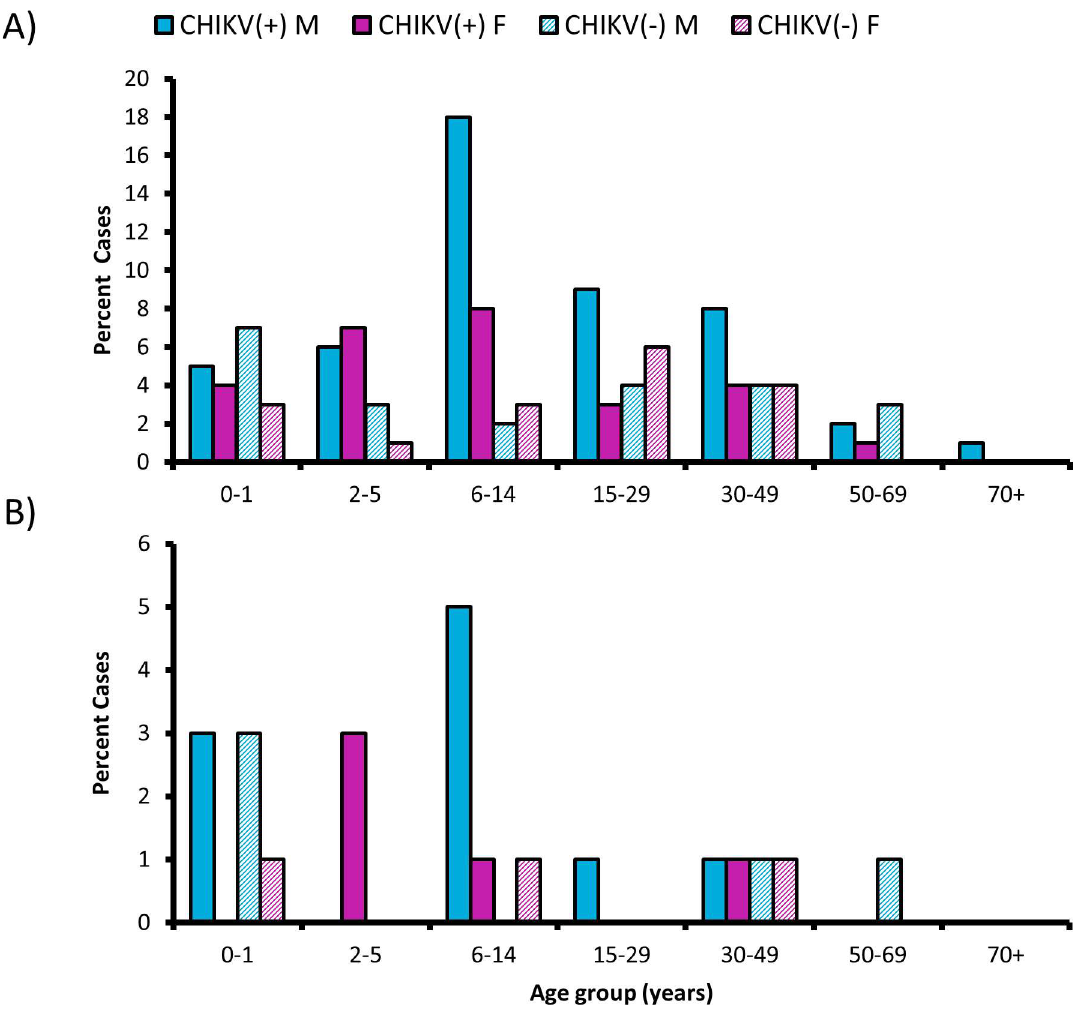
Fig 2. Age and gender distribution of patient sample pool. Serum from patients visiting an emergency clinic in the DR was tested for CHIKV RNA and IgM, and results were retrospectively matched to demographic data. A) The age and gender distribution of CHIKV-RNA positive [CHIKF(+)] and CHIKF(-) (both IgM and RNA negative)patients. The majority of patients were under the age of 50 for both CHIKF(+) and CHIKF(-) groups. B) The age and genderdistributionof patients who were